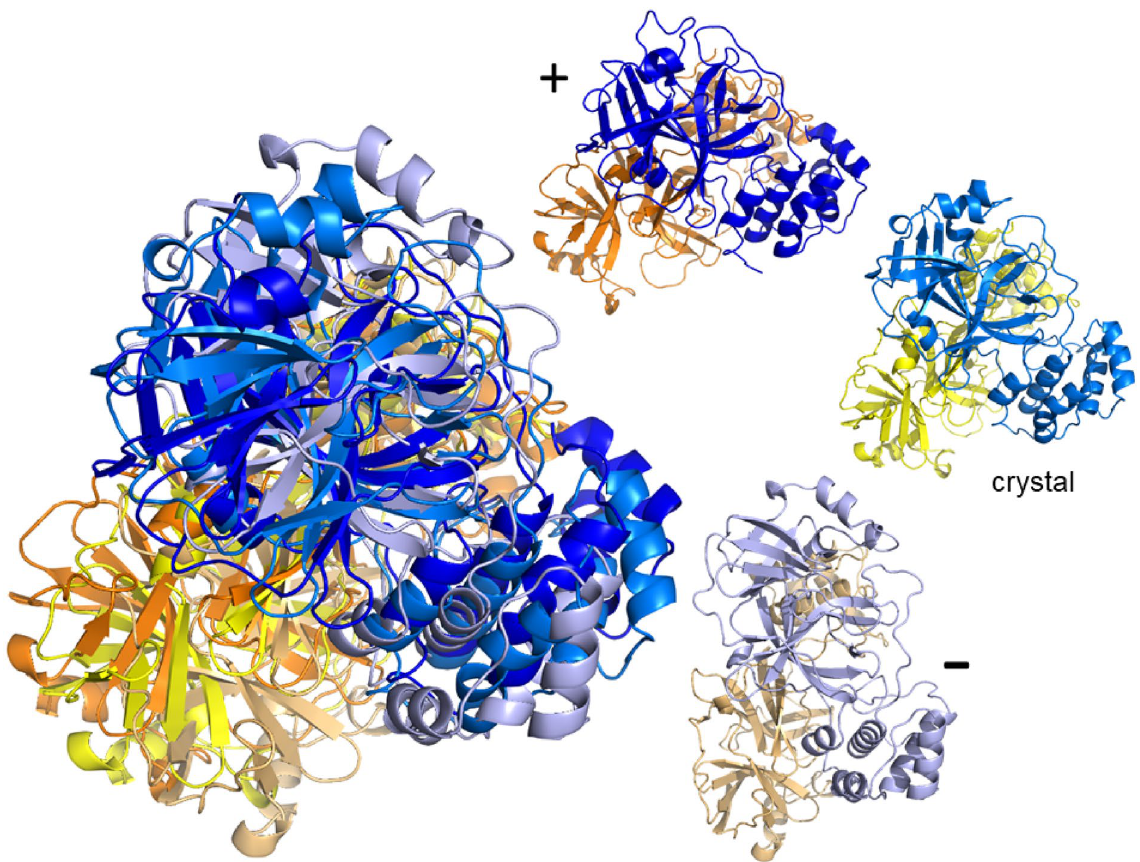
Figure 4. Example of flexible motion for mode m 7 of the dimer of main protease (PDB: 6lu7) at E cut = 2 kcal/mol . The crystal structure of the dimer is superimposed with its extreme structural positions according to mode m 7 . Chain A is denoted yellow and its extremal structures colored as in Fig. 3 light orange/ orange; chain B is indicated in blue with extremal positions in light and dark blue. The smaller protein structures show the initial (crystal) structure as well as the extremes ( + , –) along the possible motion directions for m 7 in the same colors as in the superimposed